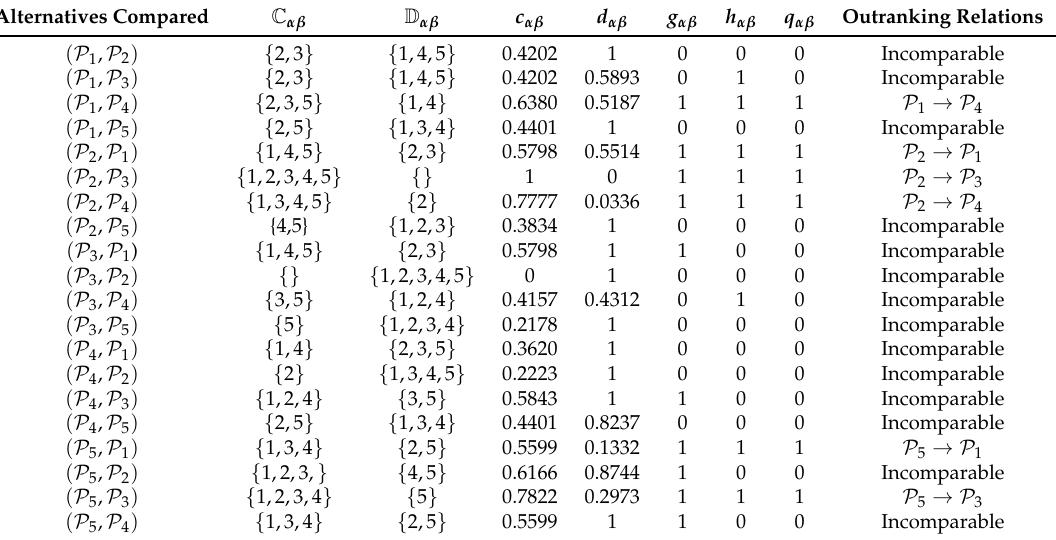
Figure 5. Graph representing the outranking relation of alternatives. Table 10. Bipolar Fuzzy ELECTRE I results for selection of Business